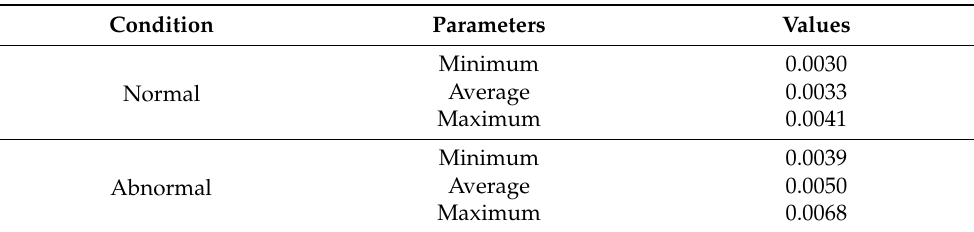
Table 4. Minimum, average, and maximum values of the differences between pulsating pressure images and transformed images .